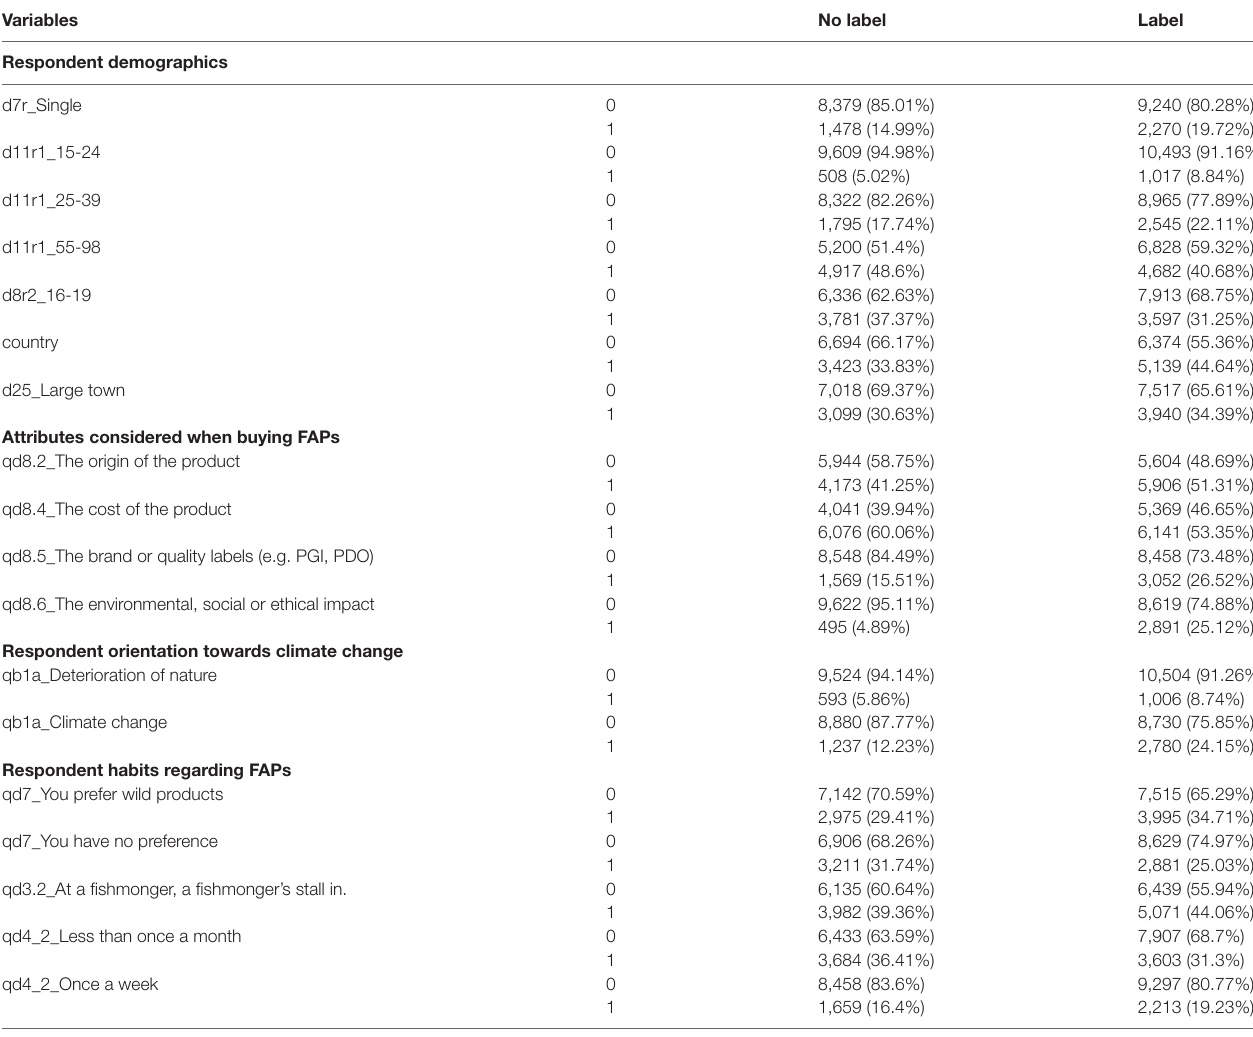
TABLE 5 | Analysis results on the differences between the groups.